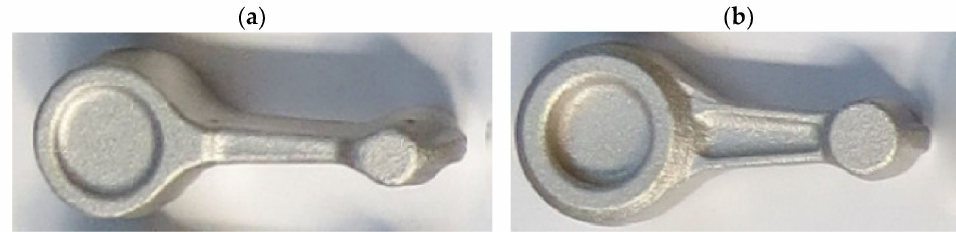
Figure 9. Pictures of connecting rod preforms: ( a ) variant 1; ( b ) variant